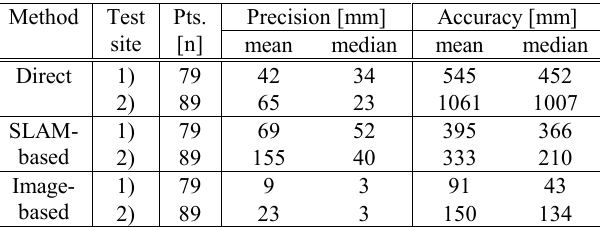
Table 3. Summary of precisions and accuracies of 3D coordi- nate observations using different georeferencing methods (Direct, SLAM-based and Image-based) for both test sites 1) “City centre” and 2) “Forest”. The table contains both the mean